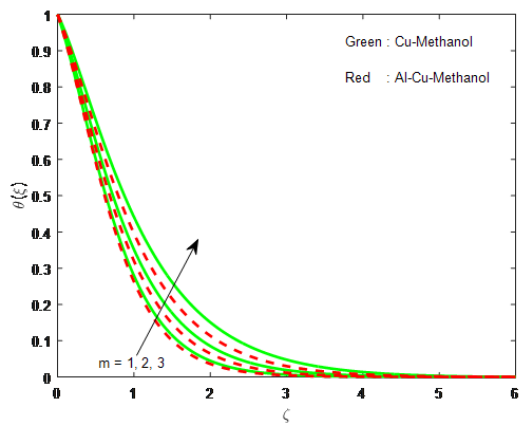
Fig. 19: Impression of Φ on θ ( ξ )